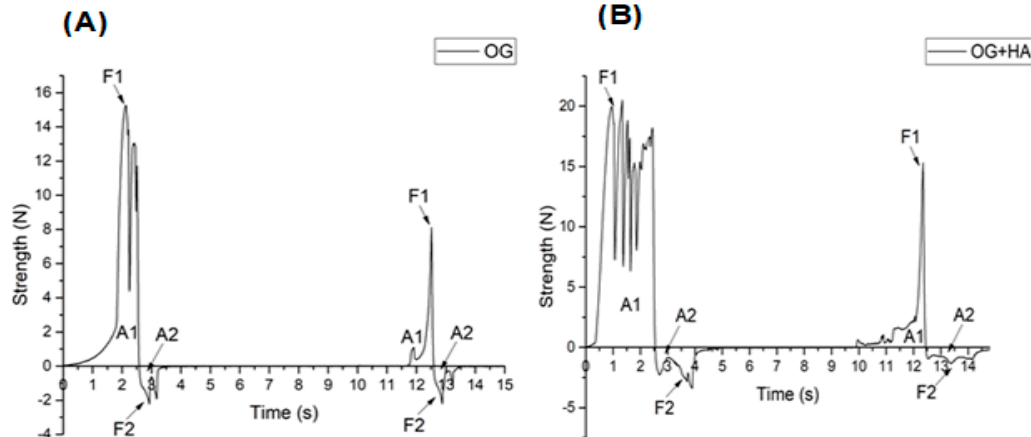
Figure 5. Strength over time in a double compression test of OG ( A ) and OG + HA ( B ).